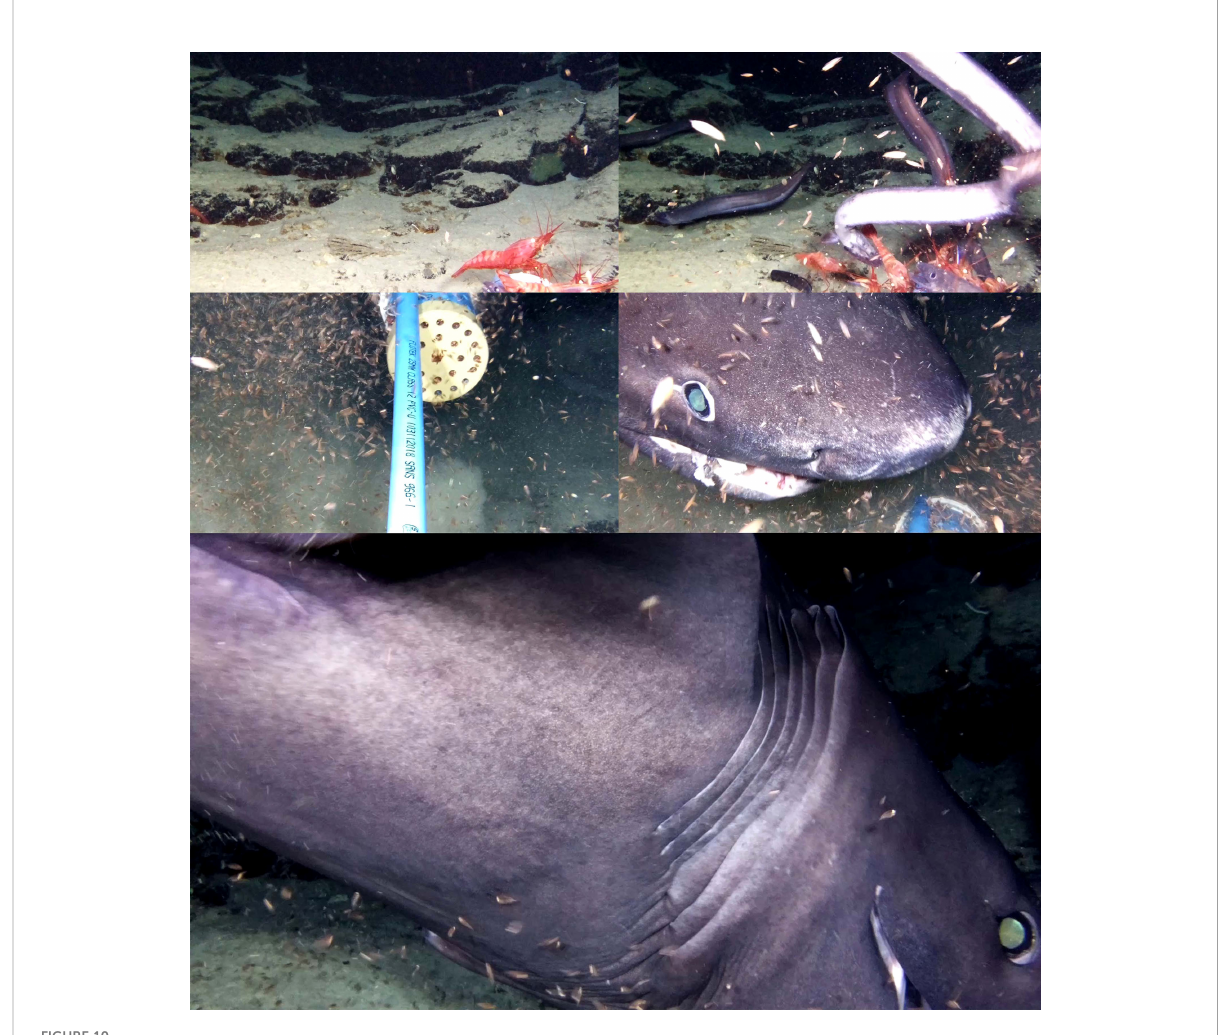
FIGURE 10 Video stills from a BRUV deployment to 900